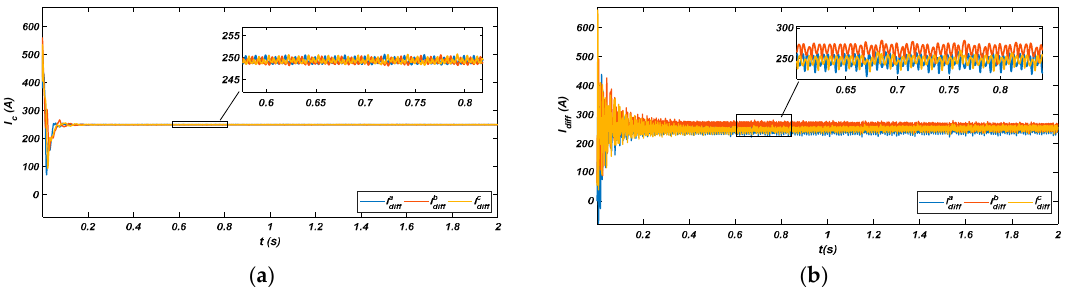
Figure 11. ( a ) Circulating current using the API controller; ( b ) circulating current using the PR controller.